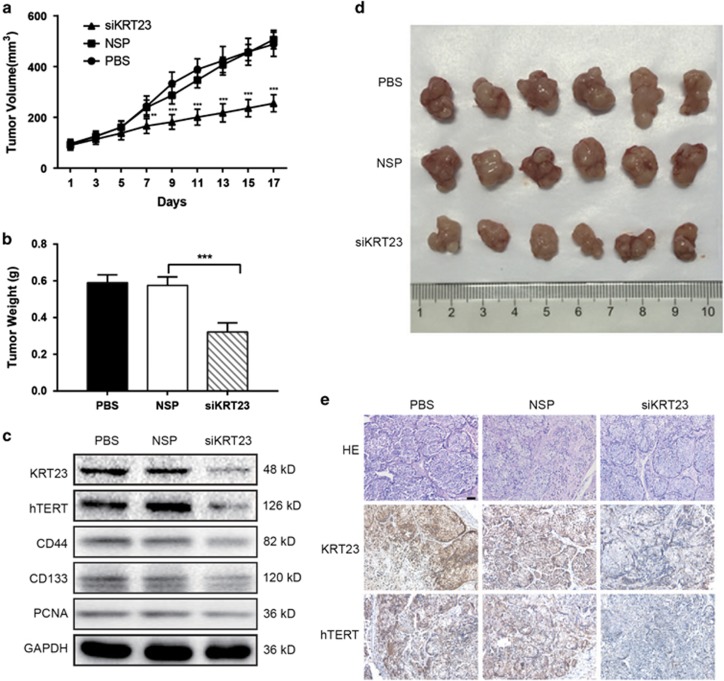
Inhibition of tumor growth by KRT23 knockdown in mice. (a) The tumor volume of each group of nude mice was measured and calculated as V=(width2 × length)/2, with n=6 and **P<0.01, ***P<0.001. (b) The weight of tumor grafts 17 days after the intratumoral injection of PBS, NSP or siKRT23-3, ***P<0.001. (c) The proteins were extracted from tumor xenografts. The KRT23, hTERT, CD44, CD133, PCNA, GAPDH expression levels were measured by western blot analysis. (d) The morphology of the tumor xenografts in each nude mouse after 17 days of treatment. (e) An immunohistochemistry assay of KRT23 and hTERT expression in tumor xenografts from each group of nude mice (× 200)